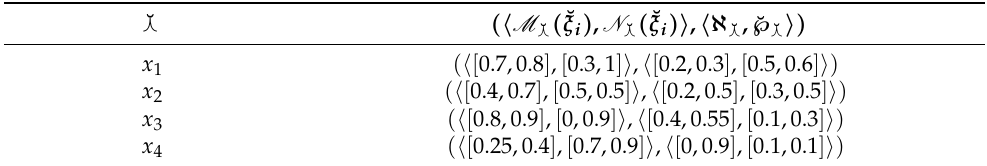
Table 2. Functionality-quality-assessed mobile phones in Example